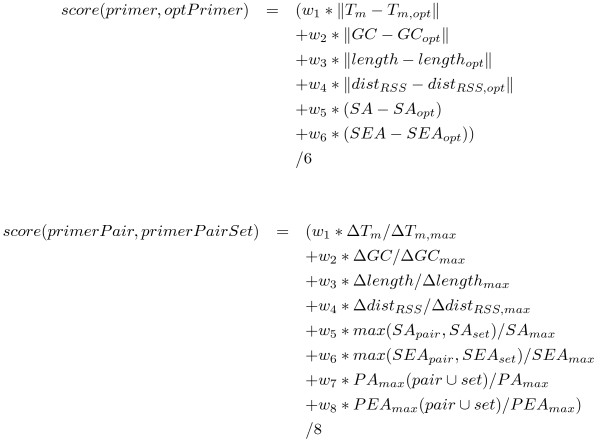
Scoring Function. The scoring function used to compare primers and primer tuples. Each component of the scoring function is weighted and weights are refinable by the user. The components are (in order of appearance): difference in melting temperature(s) (Tm) to ideal melting temperature(s) (Tm, opt), difference in GC content(s) (GC) to ideal GC content(s) (GCopt), difference in primer length(s) (length) to ideal length(s) ($length_{opt}$), difference in distance(s) to the restriction site(s) (distRSS) to ideal distance (distRSS, opt), difference in self alignments (SA) to optimal self alignment value (SAopt), difference in self end alignments (SEA) to ideal self end alignment value (SEAopt), and (only for primer pairs): difference in pair alignments of the candidat tuple and the set to which the candidate could be added (PAmax(pair ∪ set)/PAmax) and difference in pair end alignments of the candidat tuple and the set to which the candidate could be added (PEAmax(pair ∪ set)/PEAmax), respectively.